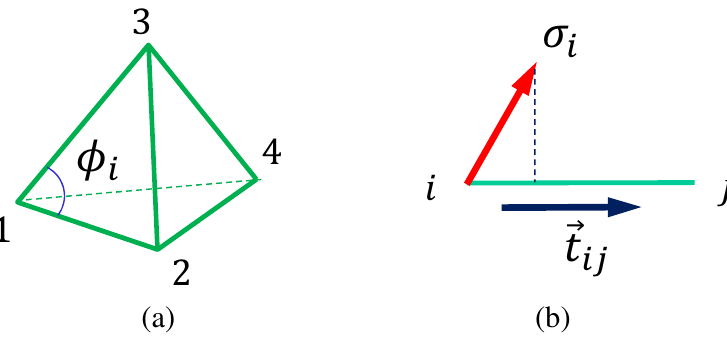
Figure 4. ( a ) A tetrahedron with vertices (1, 2, 3, 4) and an internal angle φ i of a triangle and ( b ) the variable σ i and the unit tangential vector t ij of the bond connecting the vertices i and j . The σ i and t ij are used to define v ij in Equation